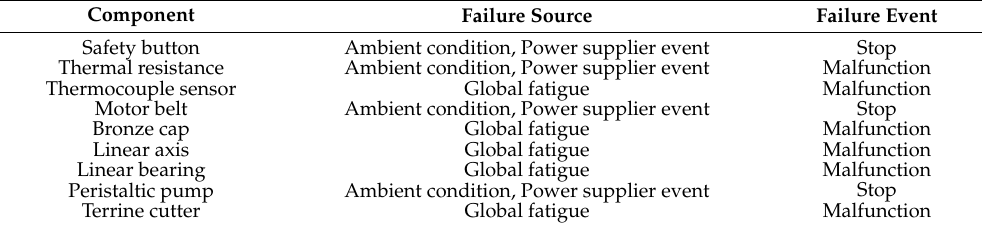
Table 3. Mechanical components in the studied MSTM with failure source and event.